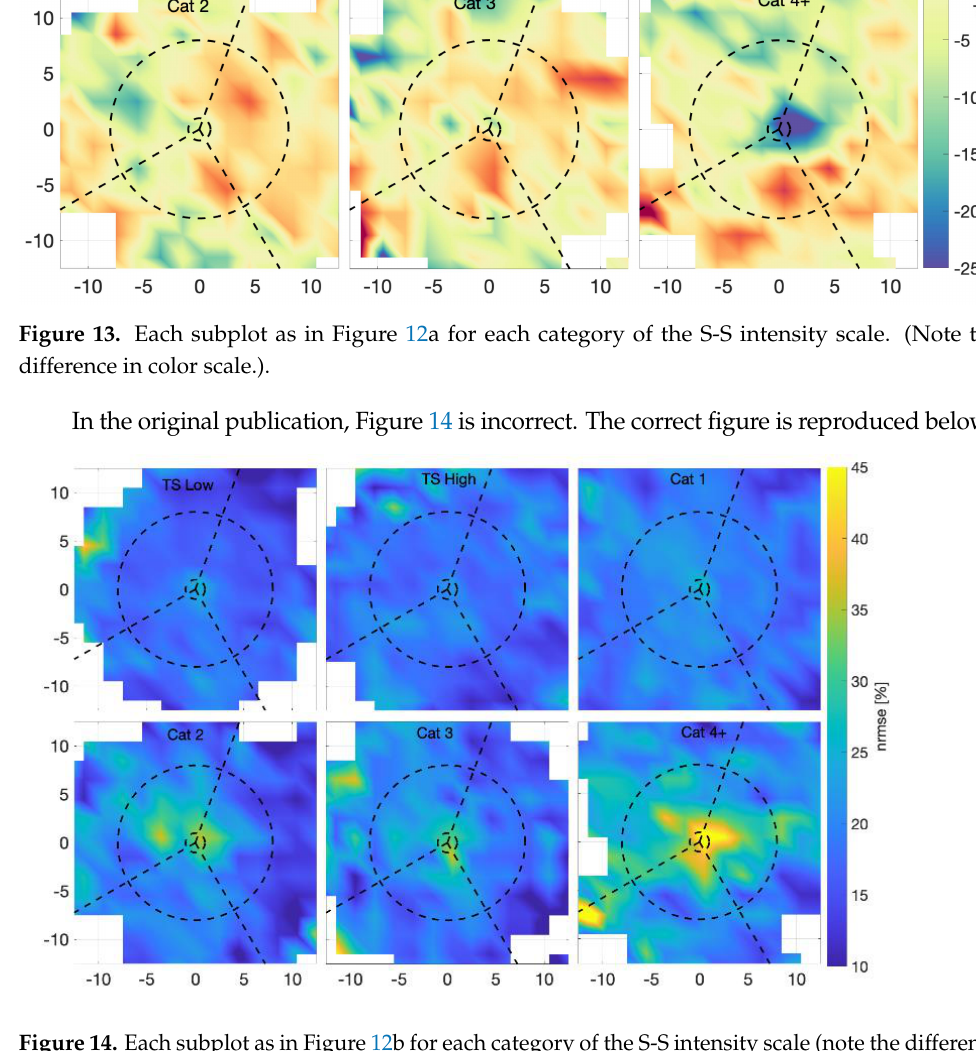
Figure 14. Each subplot as in Figure 12b for each category of the S-S intensity scale (note the differ- in color ence in color scale.).